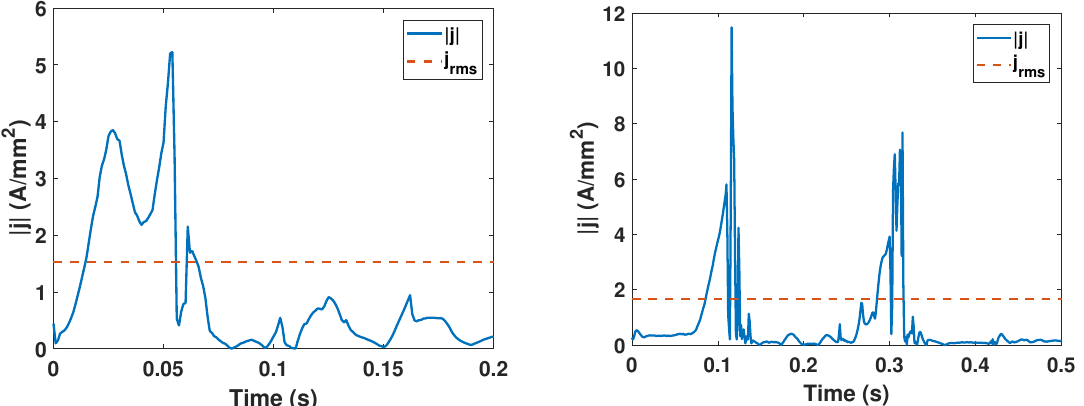
Figure 14. Coil current density during the two profiles. RMS value is computed over the duration